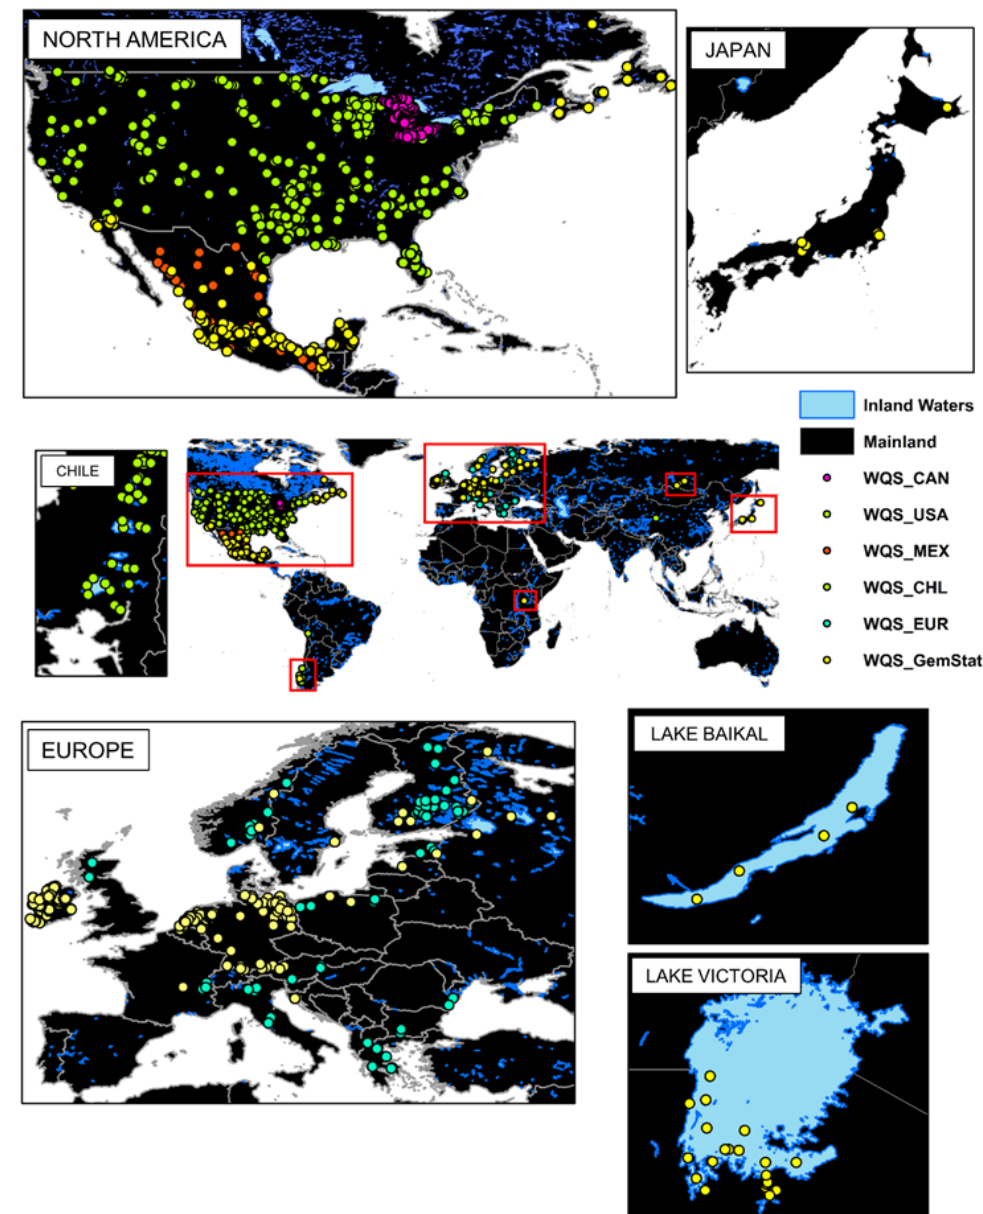
Figure 1. The global location of all the stations from the above-mentioned data sources in raw form.